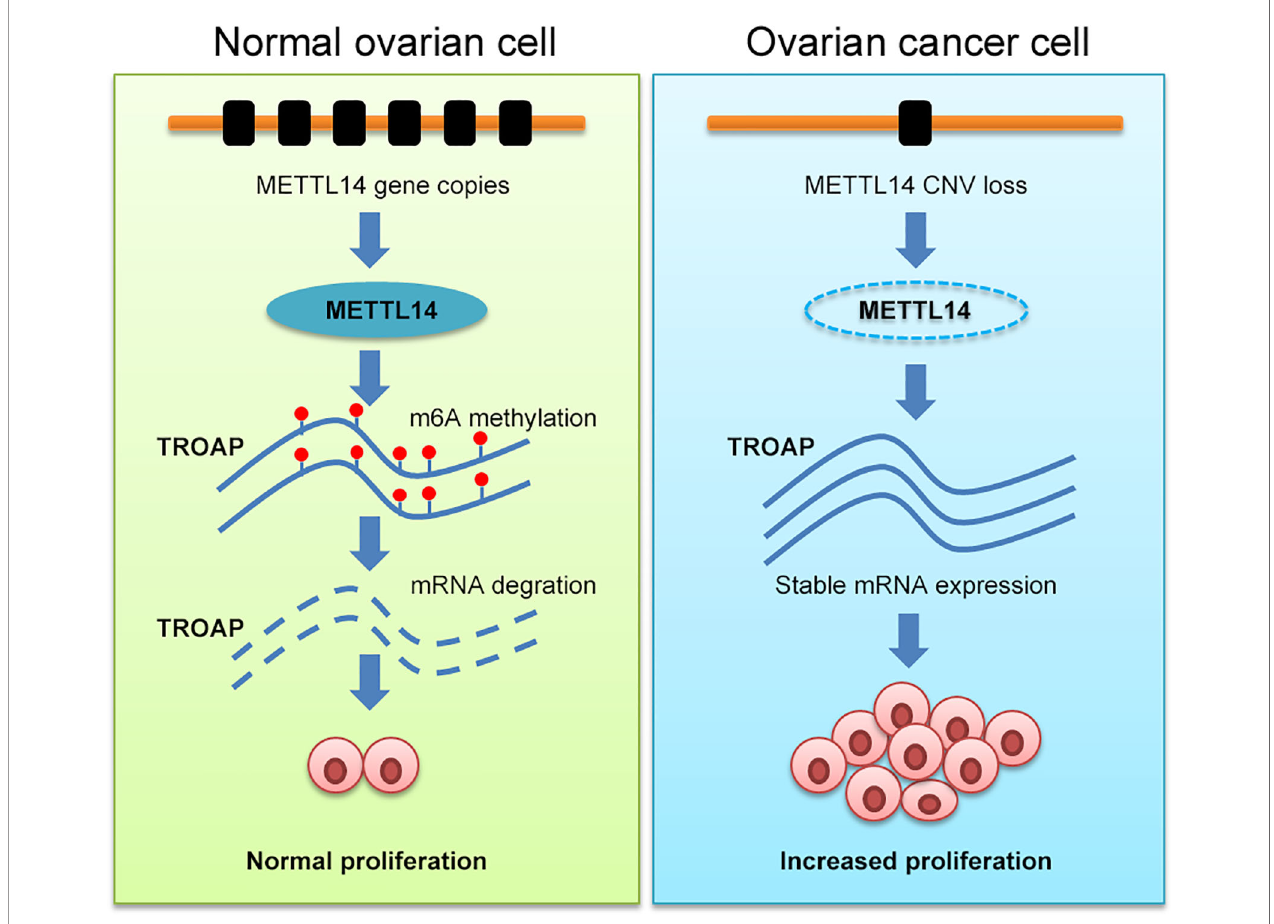
FIGURE 8 | Schematic illustration of the regulatory role of METTL14 via its m 6 A RNA methylation function on TROAP expression and ovarian cancer cell